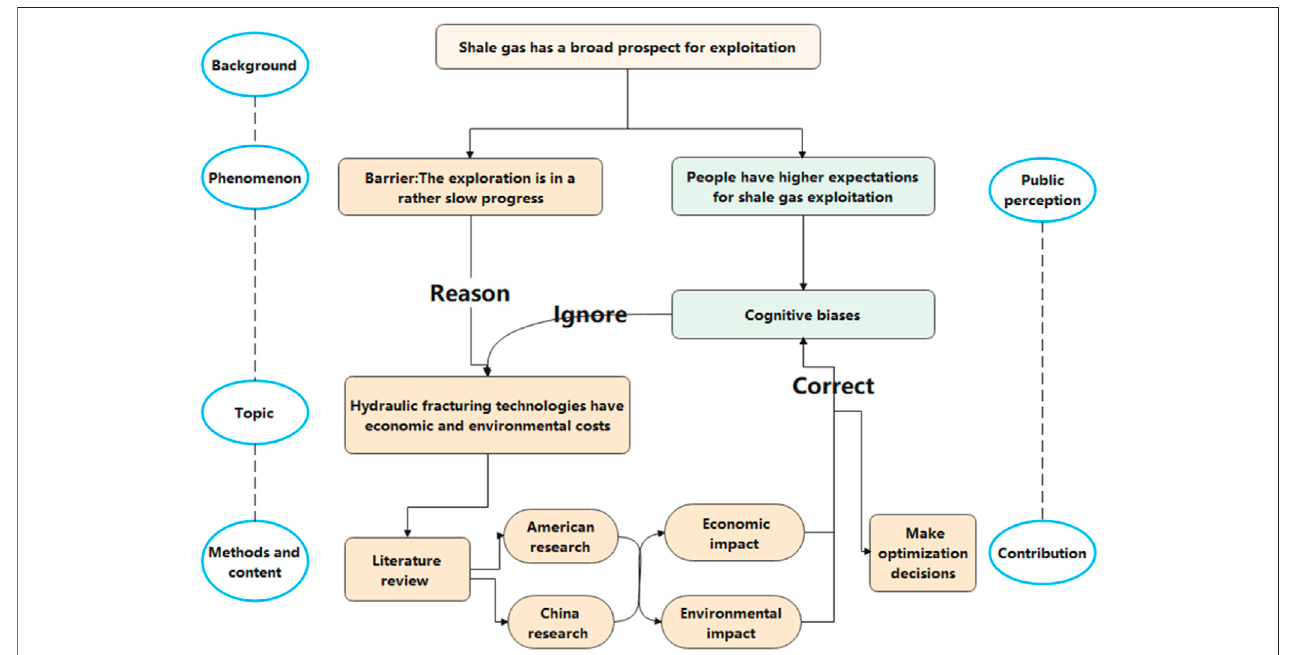
FIGURE 1 | General research